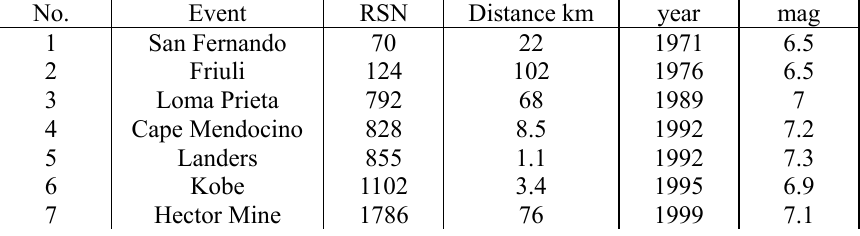
Specifications of the